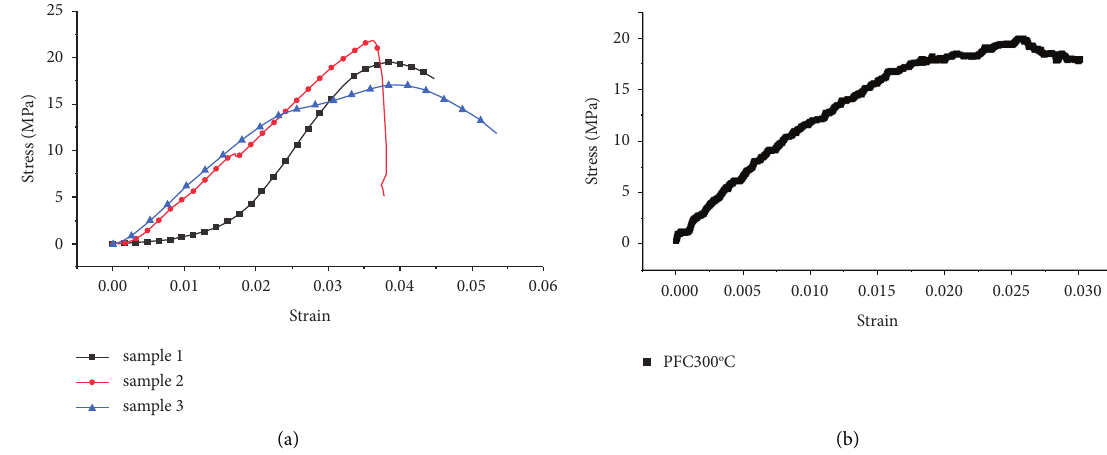
Figure 15: The concrete UCT stress-strain curves at 300 ° C: (a) the experiment results and (b) the PFC 2D result.